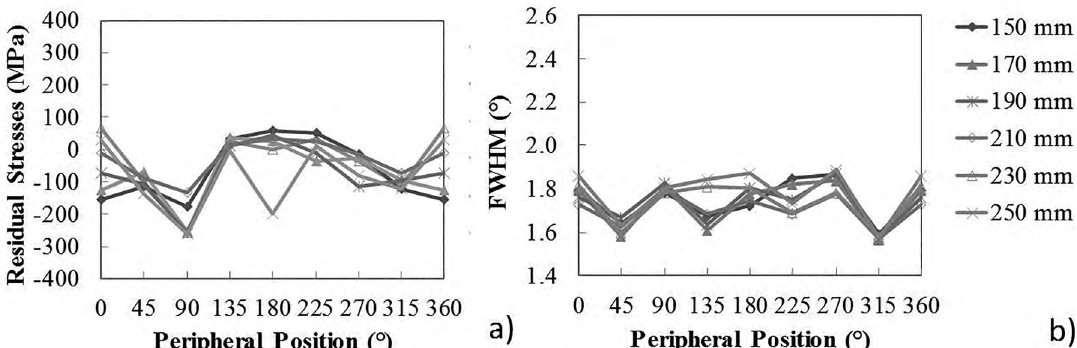
Figure 11. Residual stresses in 50 µm depth after vertical pre-straightening (a) and FWHM (b).